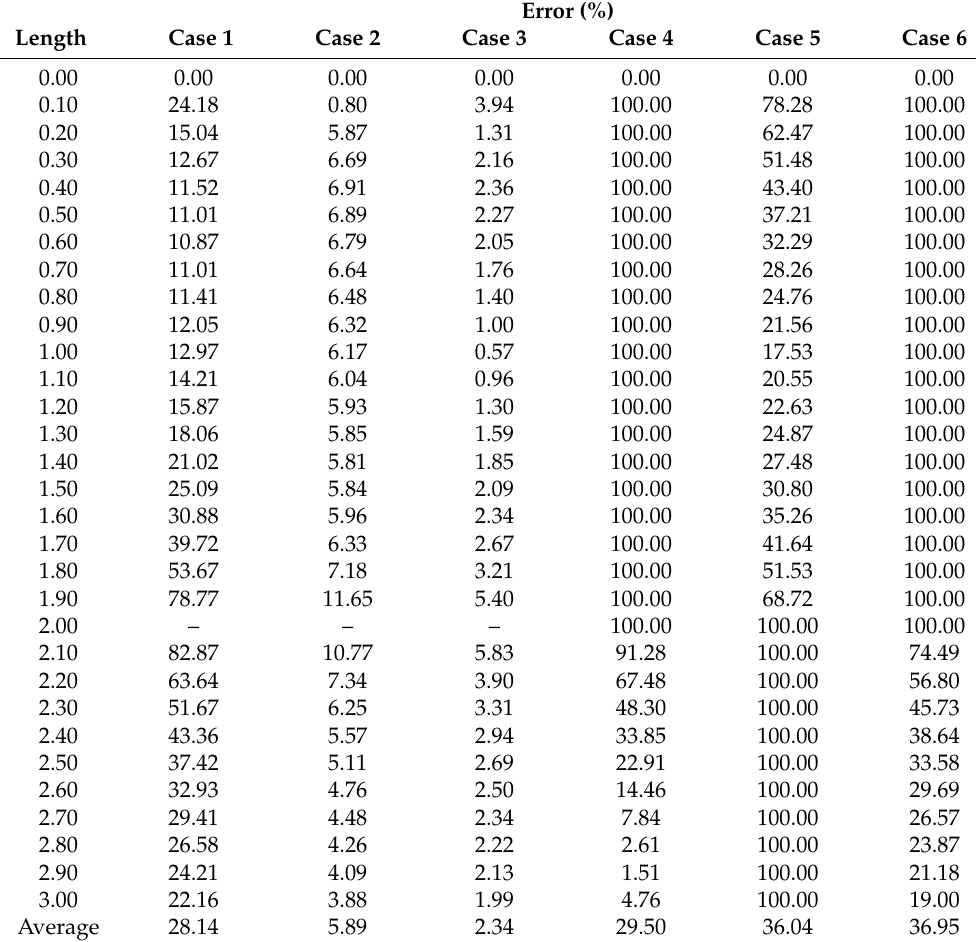
Table A4. Ful error table for two pinned supports with cantiliever